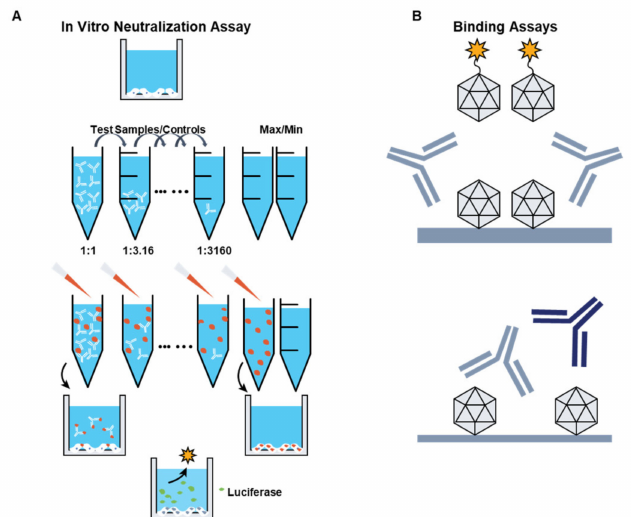
Figure 4. Assays to test for anti-AAV antibodies and neutralizing factors. ( A ) The cell-based trans- duction inhibition assay measures the ability of plasma samples to reduce the transduction of a cell line by a recombinant adeno-associated virus (rAAV) vector carrying a reporter transgene such as lu- ciferase. In the presence of antibodies, the luciferase-reported fluorescence may be reduced. ( B ) Total anti-AAV antibodies assays on human plasma using a bridging electrochemiluminescence assay or a classic capture assay. AAV capsids are coated to a well, plasma samples are added after blocking, and AAV-specific antibodies are detected using ruthenylated AAV capsids (for electrochemiluminescence assay) or an anti-IgG antibody is added (for the capture assay). max, maximum; min, minimum. Capsid T-cell responses are less readily detectable than humoral immunity in healthy individuals [11,28,58,70]. One study identified AAV capsid T-cell epitopes in human splenocytes from 44 healthy blood donors and found T-cell responses to the AAV capsid in 16.67% of children under 5 years old and in 73.08% of those ≥ 5 years old [71]. Another study found AAV-specific T-cells in splenic samples of 62.5 and 57.14% of healthy children and adults, respectively [16]. A study of peripheral blood mononuclear cells (PBMCs) found AAV1 capsid-specific T-cells in 29.1% of healthy adults donors [72], whereas